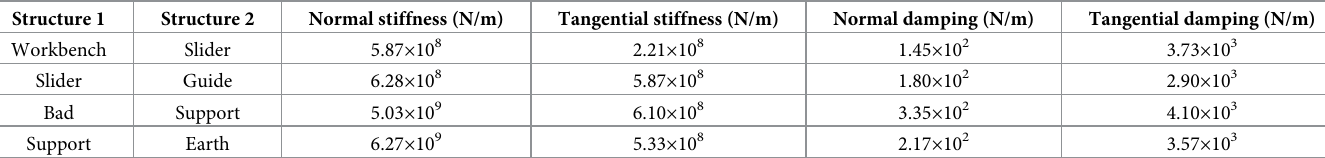
Table 2. Joint stiffness and damping characteristics.